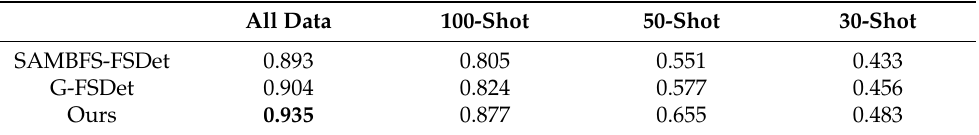
Table 6. Ship detection results (AP) of different few-shot learning